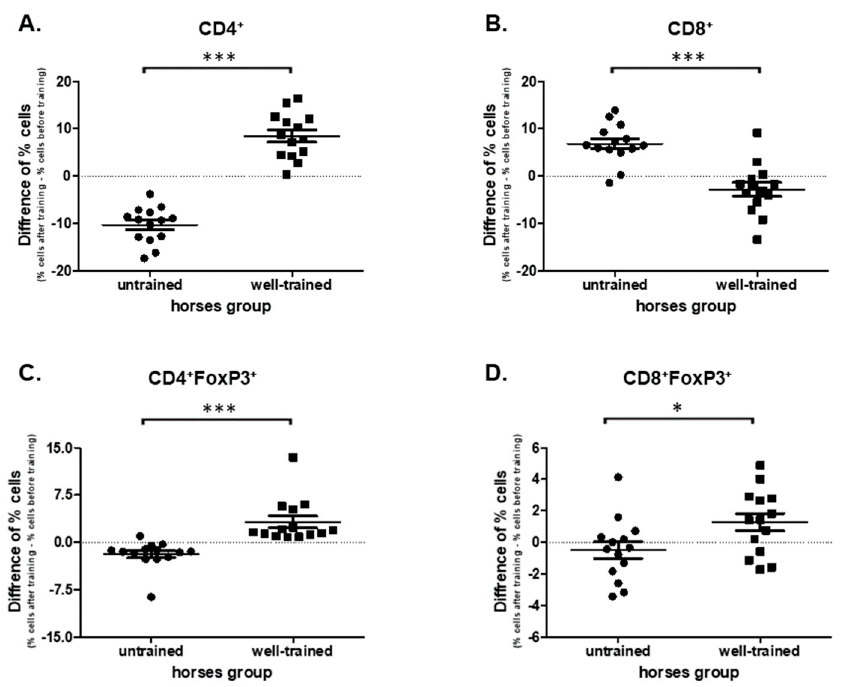
Figure 3. Graphic representation showing percentages of positive cells: CD4 + ( A ), CD8 + ( B ), CD4 + FoxP 3 + ( C ), and CD8 + FoxP 3 + ( D ) gated from total lymphocytes. The results are presented as the mean ± SEM. Significance levels are: * p < 0.05; *** p < 0.001.